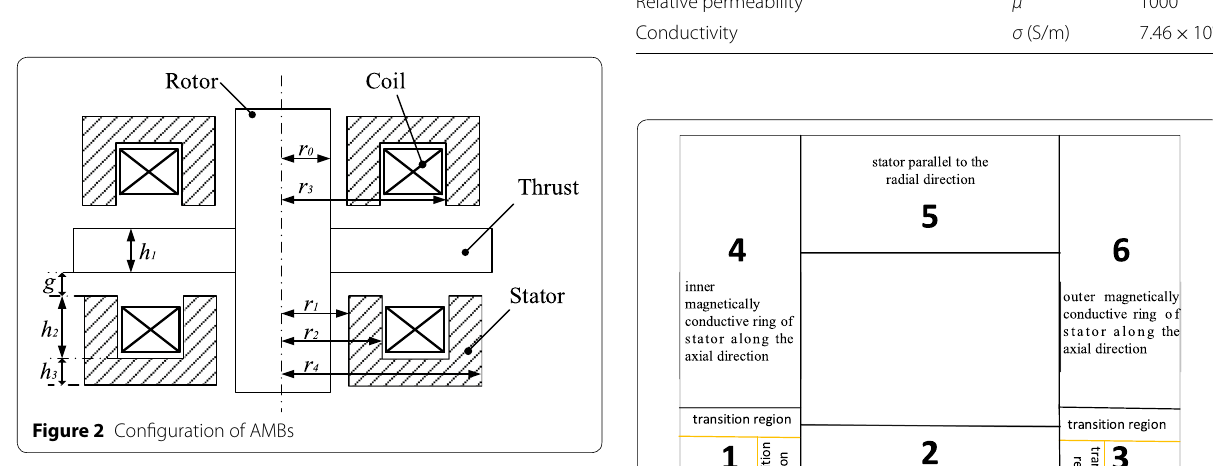
Figure 1 Magnetically suspended molecular pump model